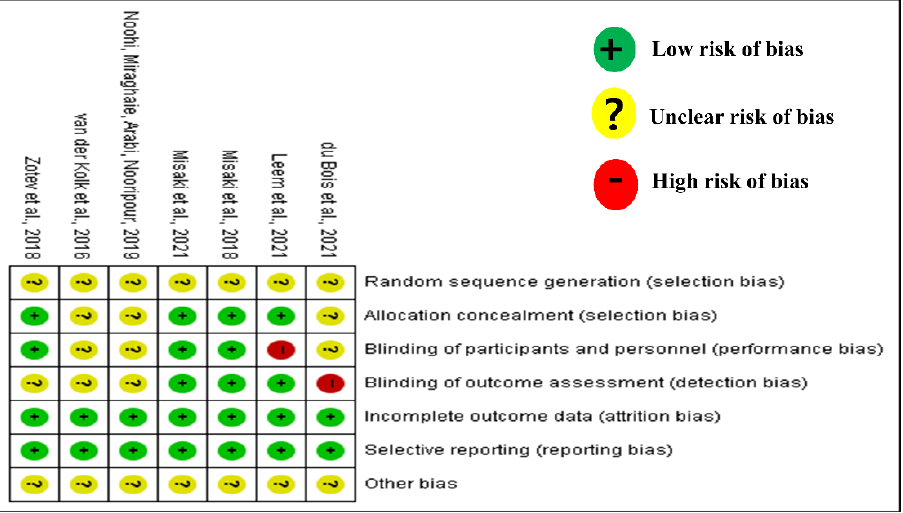
Figure 10. Summary of Cochran risk of bias in RCTs. Green indicates low risk of bias, yellow indicates unclear bias, and red indicates high bias risk. Misaki et al (2018) [26]; Misaki et al (2021) [27]; Zotev et al (2018) [28]; vander Kolket et al (2016) [29] du Bois et al (2021) [30]; Leem et al (2021) [31].